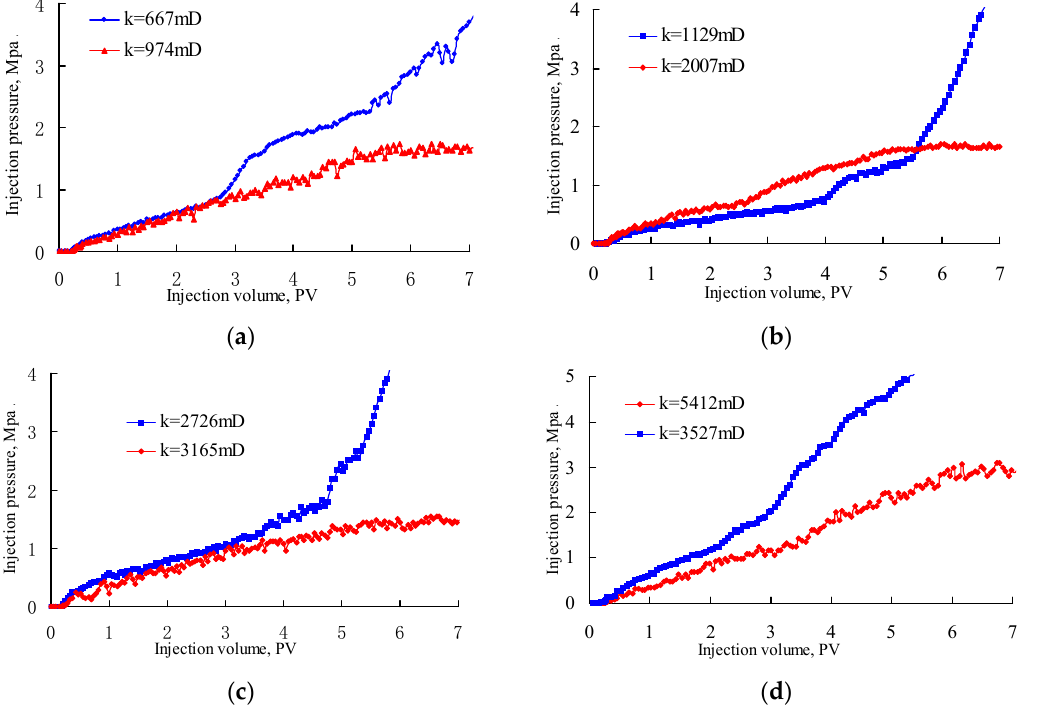
Figure 4. Injection pressure versus injection volume of PPGs (2–4 Pa) with different powder sizes: